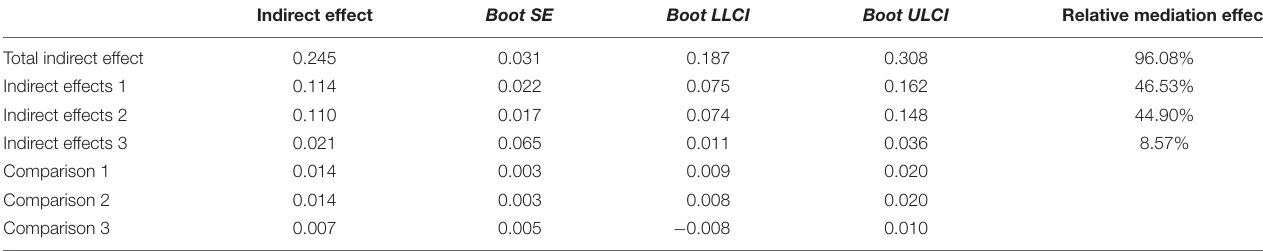
TABLE 3 | Bootstrap analyses of mediating